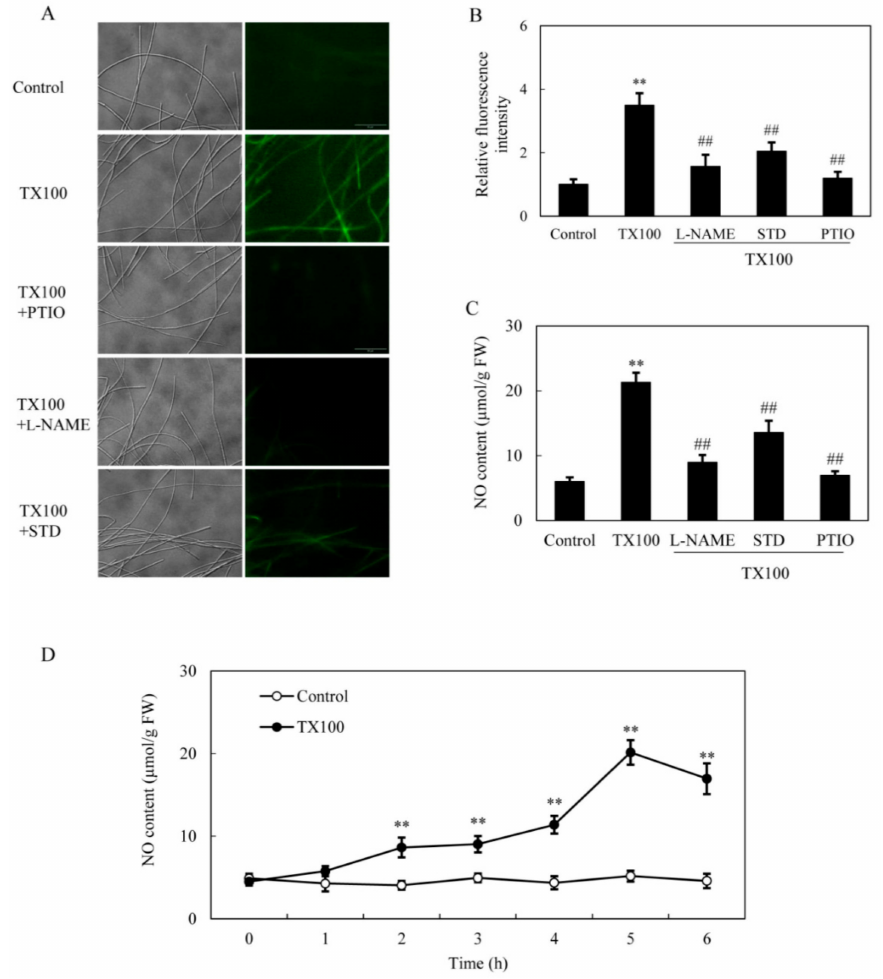
Figure 3. NO generation in the extractive fermentation. ( A ) Bright-field image (left) and fluorescence microscopy of DAF-2 DA-stained mycelium (right) in cultures. TX100 was added at 25 g / L at 36 h of the fermentation. PTIO (100 µ M), L-NAME (100 µ M) or STD (100 µ M) was added 30 min prior to TX100 treatment respectively. The photo was taken after 5 h of TX100 treatment. NO accumulation (relative fluorescence intensity) ( B ) and NO content ( C ) in mycelium after TX100 treatment. ( D ) Time-course of NO contents in mycelium after TX100 treatment. Values are mean ± SD from three independent experiments ( ** p < 0.01 vs. control, ## p < 0.01 vs. TX100